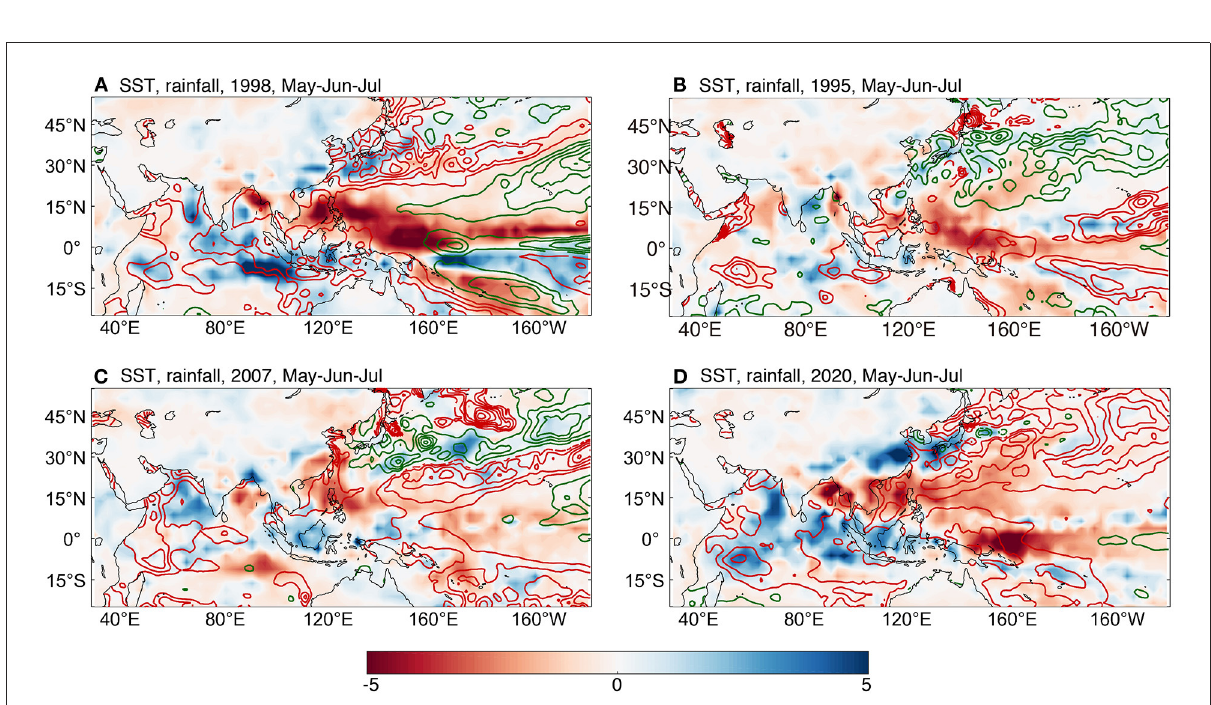
FIGURE12 June to July, SST anomalies (contours, ◦ C), rainfall anomalies (shadings, mm/day) of 1998 (A) , 1995 (B) , 2007 (C) and 2020 (D) . The anomalies are relative to 1982-2021. SST is from OISST, and Rainfall is from CMAP (Xie and Arkin, 1997).